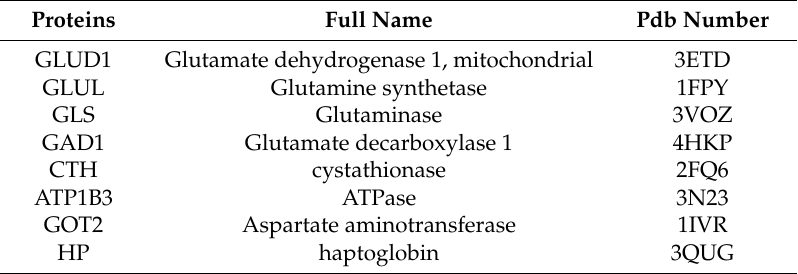
Table 6. The abbreviations, full names and PDB numbers of 8